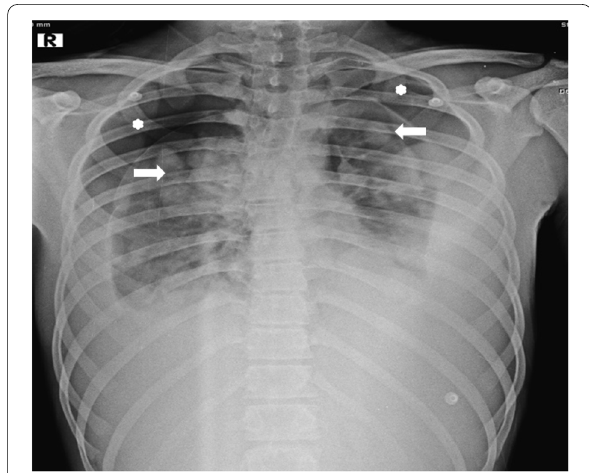
Fig. 4 Bilateral hydropneumothorax with multiple pulmonary metastatic nodules